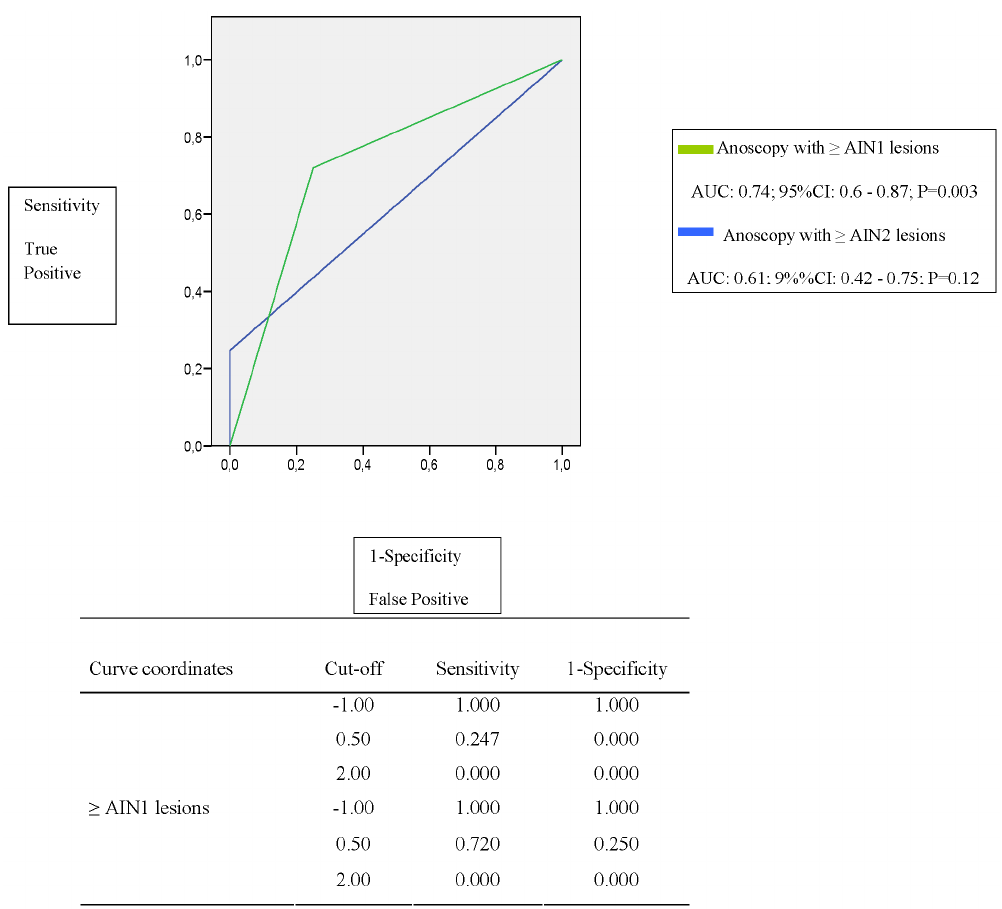
Figure 1. ROC curve of HR-HPV-negative and normal cytology vs. $ AIN 1 and $ AIN 2 lesions.